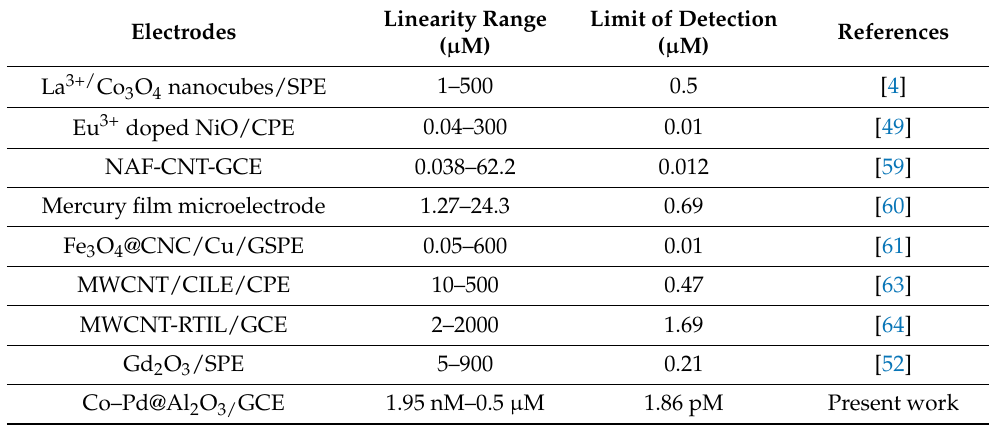
Table 1. The comparison of the reported detection limits of VEN with this work.